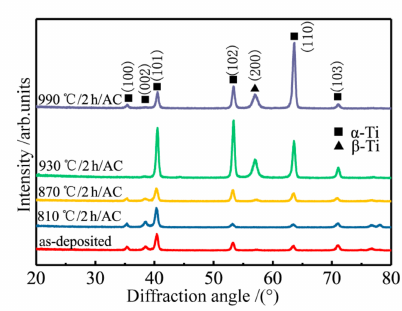
Figure 8. XRD patterns of LDF TC4 titanium alloy under di ff erent heat treatments.